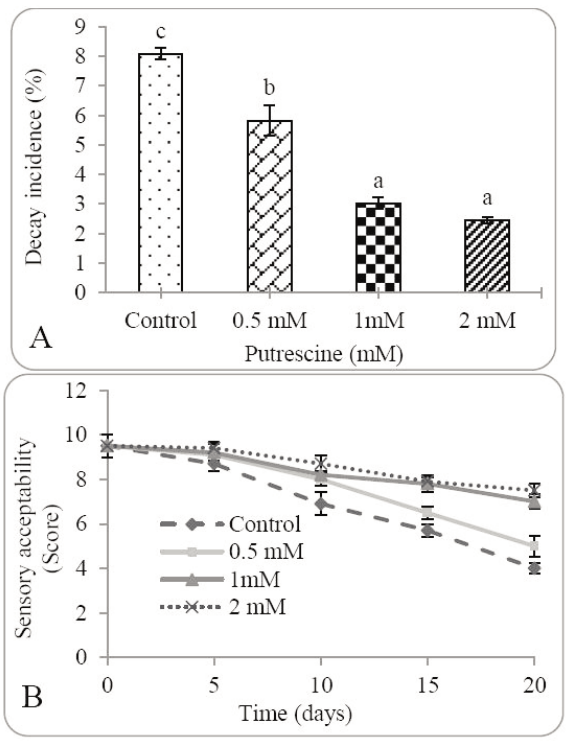
Fig. 6 - The effect of putrescine at different concentrations (0.5, 1 and 2 mM) on decay incidence (A) and sensory accept- ability (B) of Musa acuminata L. during